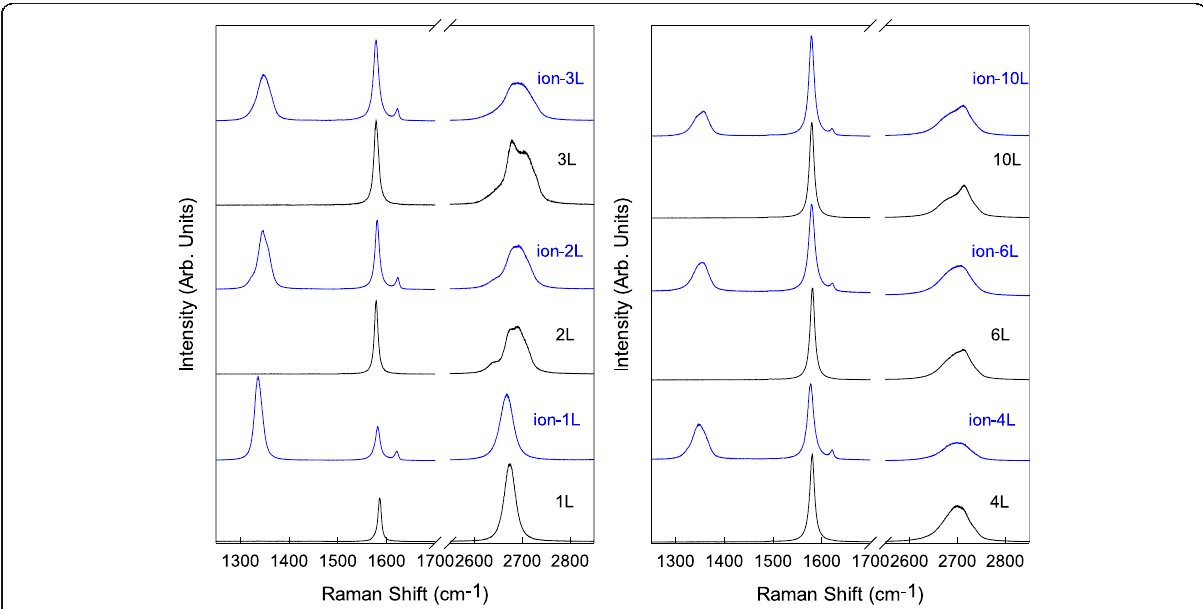
Fig. 1 Raman spectra of 1LG-4LG, 6LG, and 10LG for defect-free and defective sets were measured at room temperature in the range of 1250 – 2850 cm −